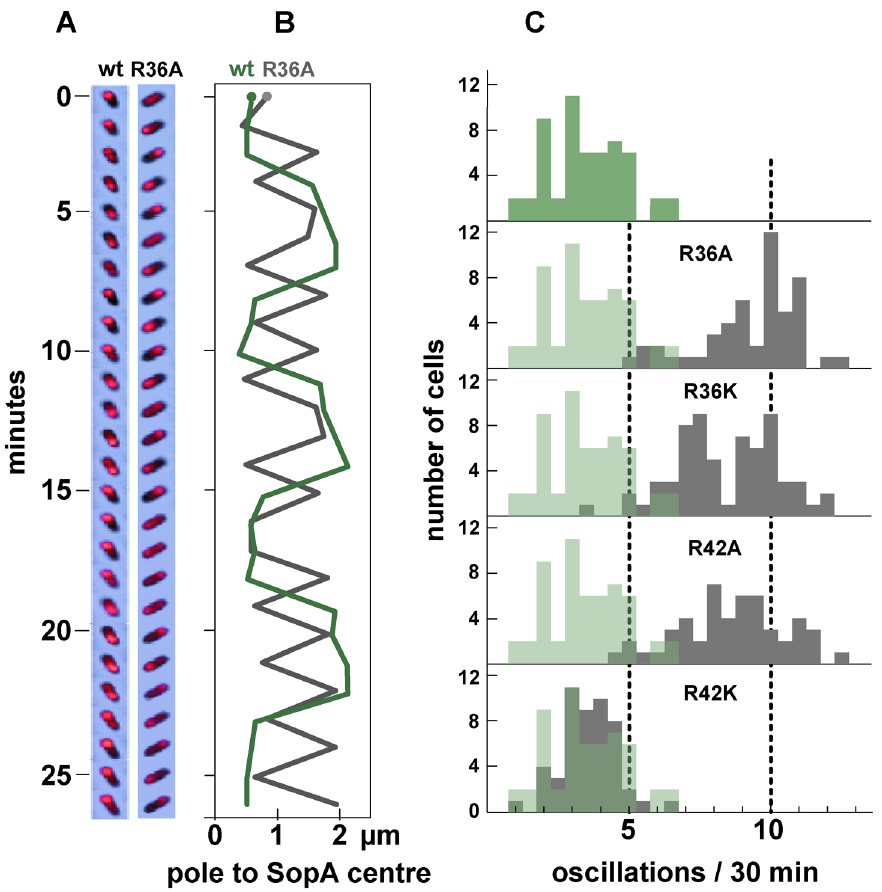
Figure 3. Effect of R36 and R42 mutations on SopA movement. A. Time-lapse image series of typical DLT2687 ( plac-sopA::xfp )/pDAG848 (mini- F)) cells carrying pYAS47 ( sopA + B + ) or pYAS64 ( sopA + B R36A ) grown in MGC-IPTG (0.1 m M) medium and applied to MGC-IPTG agarose slides. Images were acquired with an Olympus microscope at 70-second intervals for 29 minutes using 0.5 sec exposure. B. Kymograph of the SopA::Xfp foci in A. Each point represents the position of the brightest pixel in the image. C. Distribution of oscillation rates in cells producing the wt and the four mutant SopBs. Rate data are binned into 0.5 oscillation/30 min intervals. The levels of SopA::Xfp and SopA were, respectively, about 3-fold and 0.3-fold the wt mini-F levels (Figure S1C); repression of the plasmid-borne plac promoter is stronger than that of the chromosomal plac in the conditions